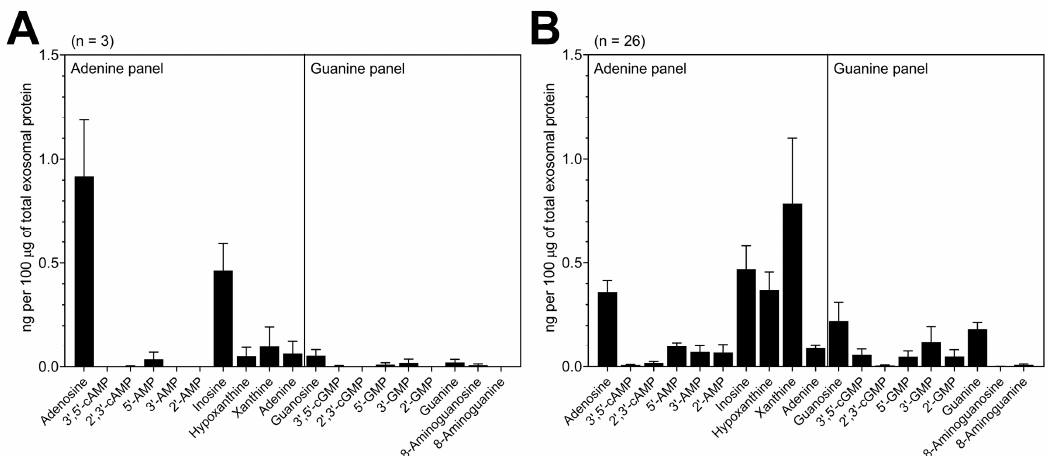
Figure 3. Exosomes isolated from the supernatant of HNSCC cells or patients’ plasma encapsulate purine metabolites. ( A ) Quantification of a selected panel of purine metabolites by UPLC-MS/MS in TEX derived from UMSCC47 cells. Results are presented in ng normalized to 100 µg of total exosomal protein. Presented are the means ± SEM of three independent experiments. ( B ) Quantification of purine metabolites by UPLC-MS / MS in exosomes isolated from the plasma of HNSCC patients. Results are presented in ng normalized to 100 µ g of total exosomal protein. Purine metabolite levels were quantified in 26 samples from individual HNSCC patients and are here presented as means ± SEM.